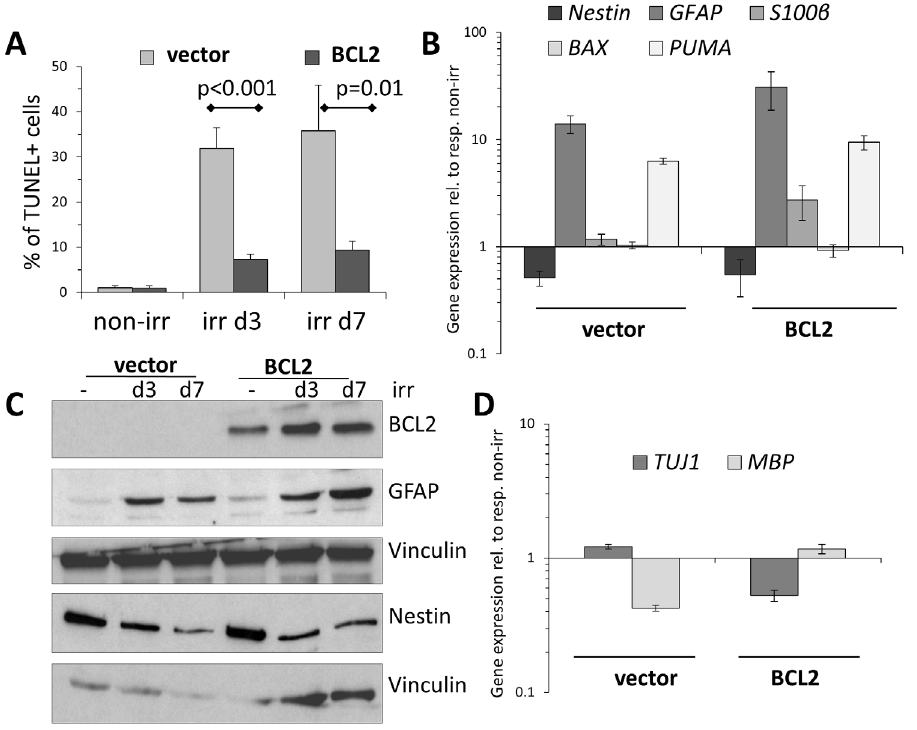
Figure 2. Inhibition of apoptosis in irradiated NSCs by BCL2 -overexpression allows a more efficient astroglial differentiation. (A)Vector-transduced or BCL2 -overexpressing NSC were irradiated, apoptotic cell death analyzed by TUNEL assay. Error bars: SD. (B)Gene expression analysis at day 3 post irradiation of vector-transduced or BCL2 -overexpressing NSC for the expression of stem cell marker Nestin , astrocyte markers GFAP and S100 b , pro-apoptotic genes BAX and PUMA , normalized against respective non-irr cells. Technical triplicates, error bars: SD. (C)Western blot analysis of vector-transduced or BCL2 -overexpressing NSC for expression of Nestin and GFAP following irradiation. Loading control: vinculin. (D)Gene expression analysis as in (A) for the expression of markers of mature neurons ( TUJ1/ b -tubulinIII ) and oligodendrocytes ( MBP ), normalized against respective non-irr cells. Cave: both gene products were detected at rather low expression levels (high qPCR-cycle number). Technical triplicates, error bars: